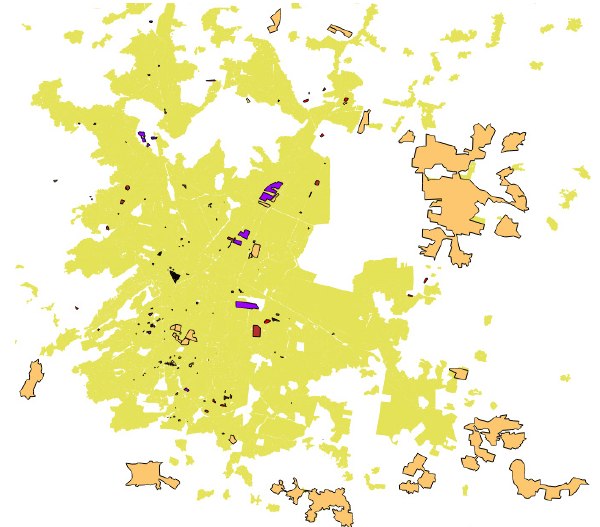
Figure 2. Built-up areas of Mexico City (OSM: light orange = “residential”, violet = “industrial”, brown = “commercial”, red = “retail”, grey = “garages”; urban-area layer: light green)